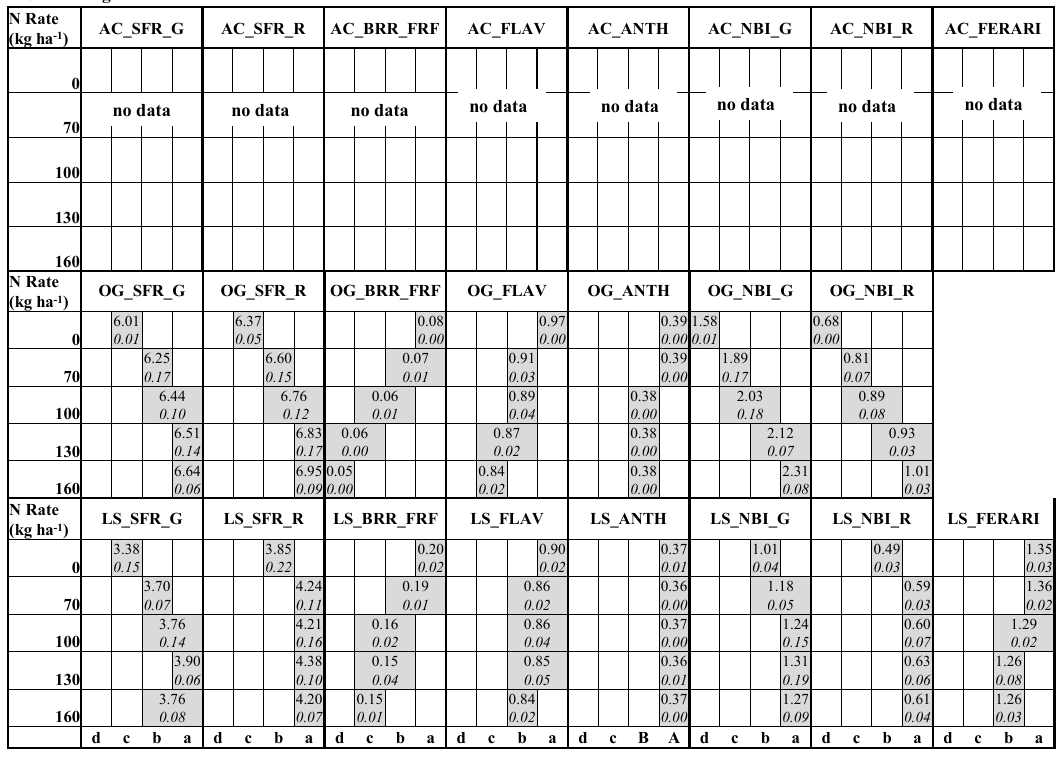
Figure 2. Mean value comparisons for each Multiplex index at the three growth stages and each N application rate (kg N ha -1 ) for variety KY 131 in 2013. Means and standard errors are shown in each cell for N rate treatments with each measurement mode (Above Canopy, AC; On-the-go, OG; Leaf Scale, LS). Different lowercase letters at the bottom of the plot at each growth stage indicate significant differences according to the least significant difference test at P ≤ 0.05.